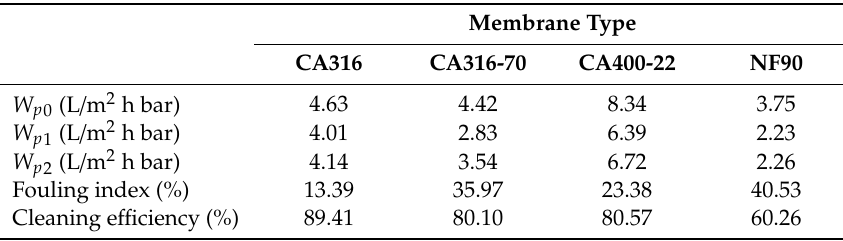
Table 6. Hydraulic permeabilities in NF / cleaning cycles, fouling index, and cleaning e ffi ciency of the selected membranes.